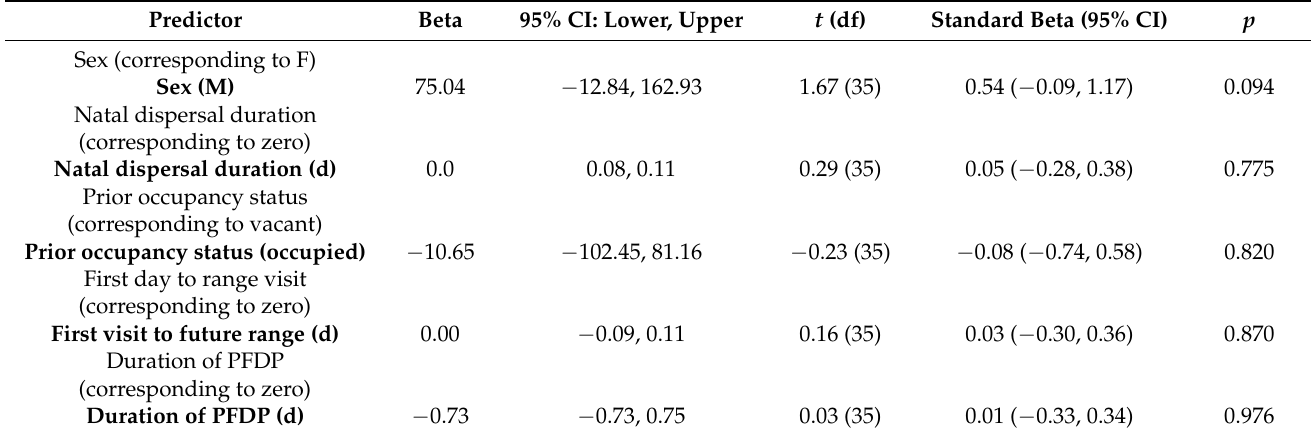
Table 3. Results of individual Gaussian GLMs estimated by maximum likelihood using number of visits to the future range as the response (dependent) variable. Prospective explanatory predictor variables involved sex (male or female), duration of natal dispersal, prior occupancy status (occupied or vacant), days to first visit after dispersing and duration of